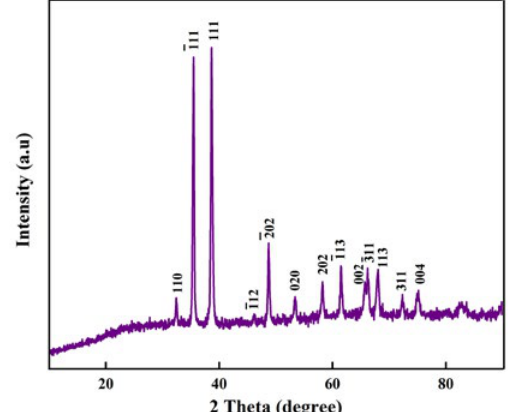
C.Fig. 3. PXRD pattern of as-synthesized CuO product by in-situ calcination of (btec)(2,2’-bipy) ] MOF. 2 2 ∞